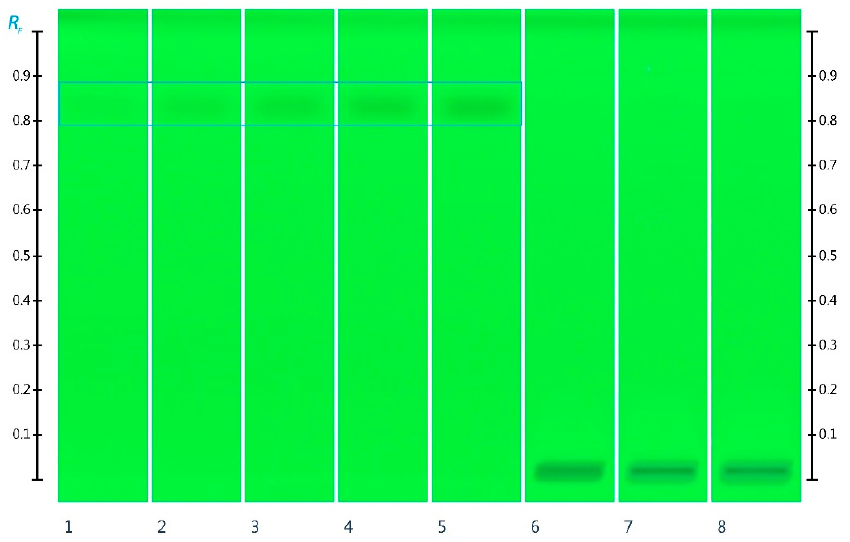
Figure 4. HPTLC images taken at 254 nm after development; Track 1, 2, 3, 4, and 5 were HMF (Rf 0.83) standard solution 1 µL, 2 µL, 3 µL, 4 µL, and 5 µL, respectively; Track 6, 7, and 8–10 µL aqueous ant honey solution .